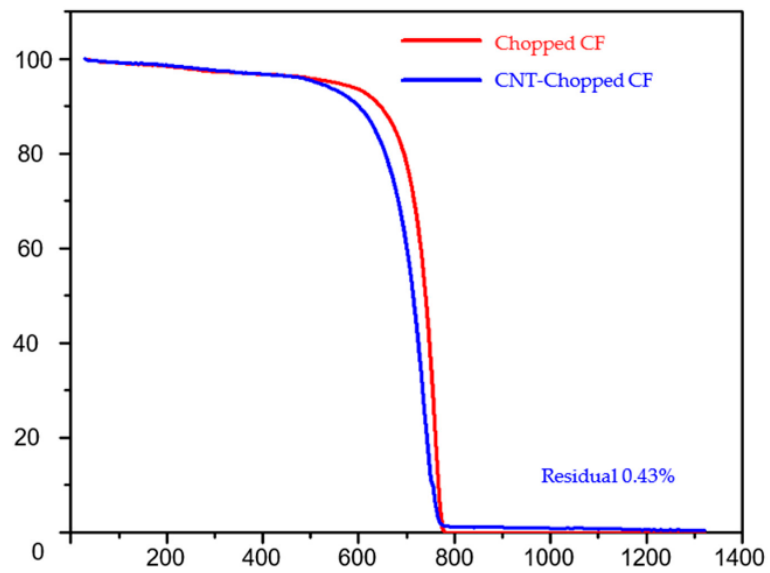
Figure 3. Thermogravimetric analysis data for chopped carbon fiber (CF) and CNT-integrated